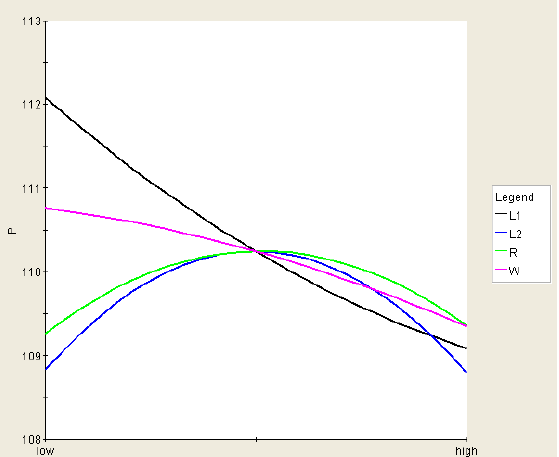
Figure 10. The main effect of each design variable on the objective function.